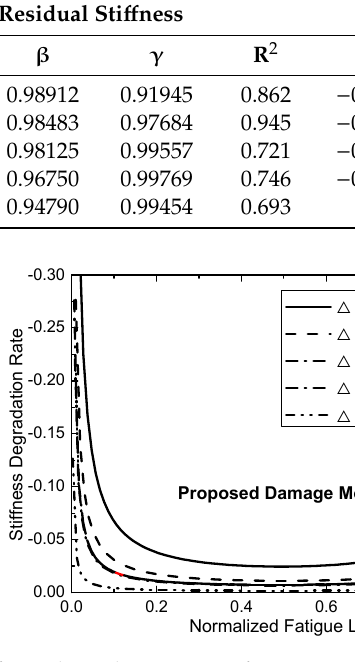
Figure 6. Sti ff ness degradation rates of CFRP tendons at di ff erent stress Figure 6. Stiffness degradation rates of CFRP tendons at different stress ranges.